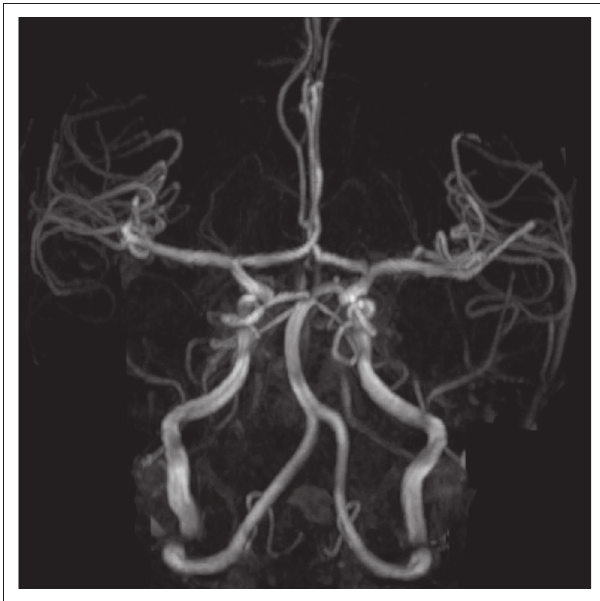
FIGURE 7: MR Angiography image of the circle of